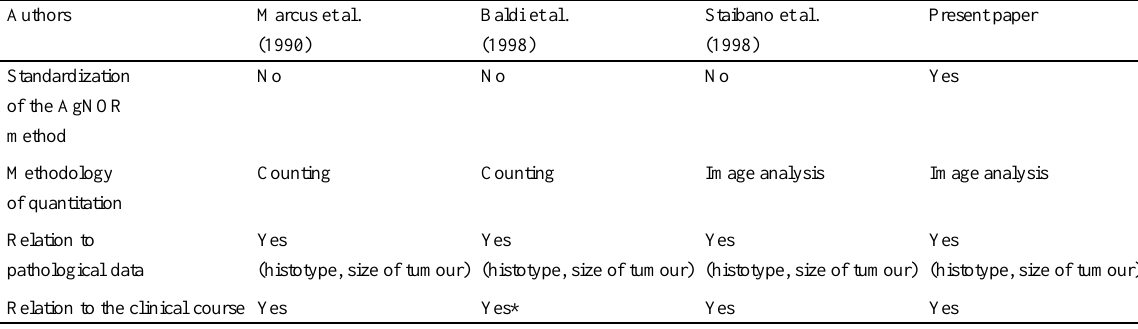
Summary of studies about AgNOR analysis in uveal